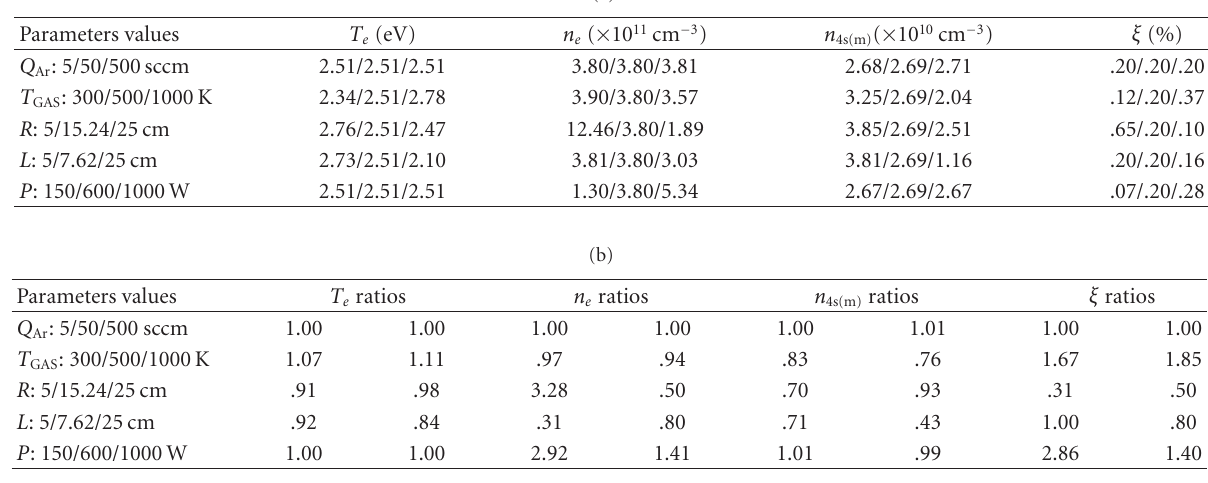
Table 7: Sensitivity of various PR parameters for a pressure of 10 mTorr, including the configuration of the available experiment